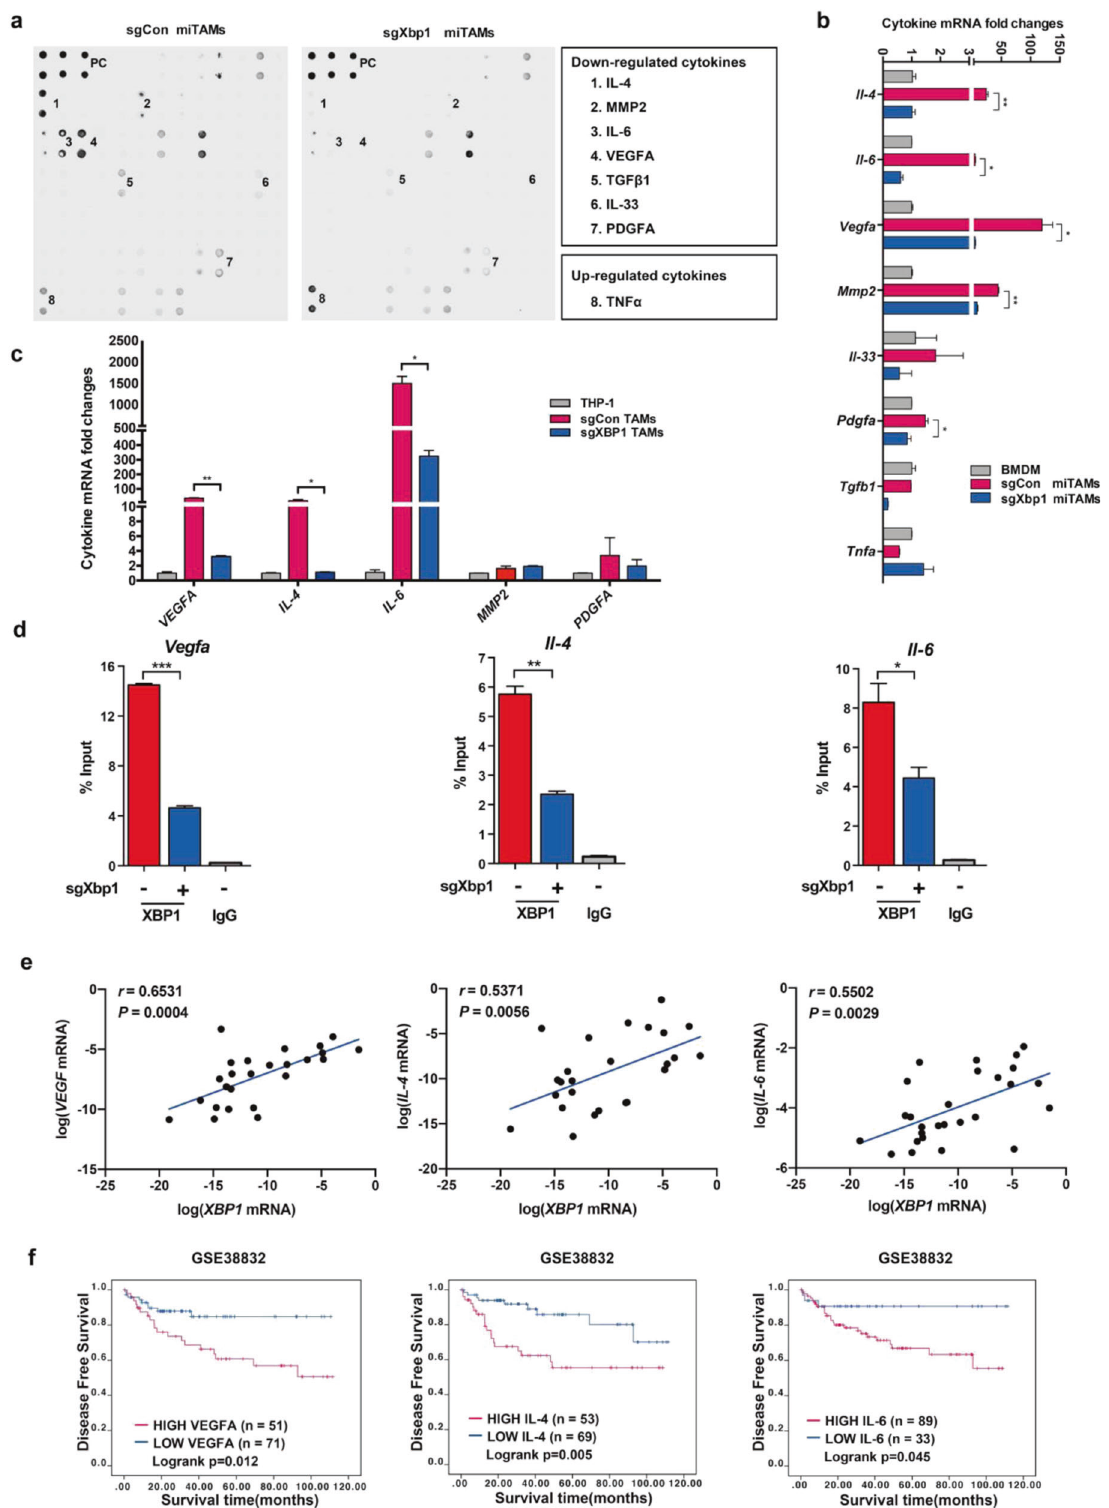
Fig. 4 Cytokines production induced by XBP1 activation in TAMs. a Representative cytokine arrays for sgCon miTAMs and paired sgXbp1 miTAMs supernatants. b Relative mRNA levels of cytokines in BMDMs, sgCon miTAMs, and paired sgXbp1 miTAMs validated by RT-qPCR. c Expression of cytokines in human TAMs. Human macrophages from THP-1 cells were induced to TAMs via incubation in condition medium of HCT116 cells, and relative mRNA levels of cytokines in THP-1, sgCon or sgXBP1 TAMs were validated by RT-qPCR. d ChIP-qPCR experiments measuring XBP1 binding on Vegfa , Il-4 , and Il-6 segments. Bars represent mean ± SD of three experimental replicates. * P < 0.05, ** P < 0.01, *** P < 0.001; t -test. e Expression of VEGFA, IL-4, and IL-6 versus XBP1s in all hTAM samples from CRC patients ( n = 27). r , Spearman ’ s rank correlation test. f Kaplan – Meier survival curves f or CRC patients with or without high expression levels of VEGFA, IL-4 and IL-6 in the GEO online database (GSE38832). The optimal survival cut point was determined via X-Tile statistical